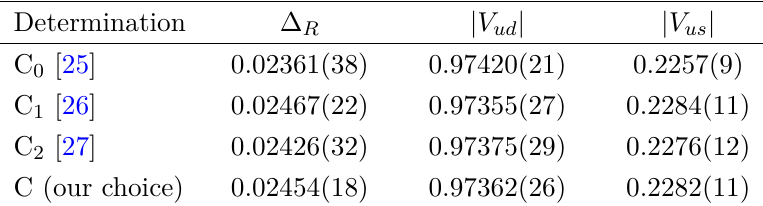
Table 1 . Values of ∆ R reported in original references [26, 27], respectively labeled as C 1 and C 2 , and corresponding values of | V ud | obtained by averaging eqs. (2.6) and (2.8). Values of | V us | are obtained assuming unitarity (1.3). C represents our average (see text). C 0 represents the value quoted by Particle Data Group (PDG) review 2018 [36].